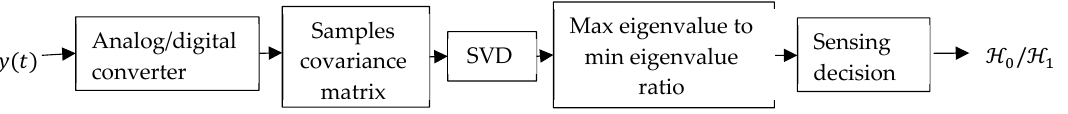
Figure 5. Block diagram of covariance-based based techniques.